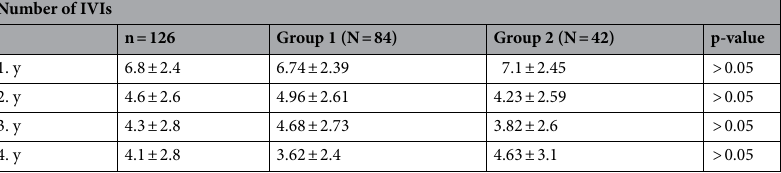
Table 3. The number of injections in both study eyes. Group 1 (response group, n = 84): eyes that showed a therapeutic response to intravitreal bevacizumab. Group 2 (non-response group, n = 42): eyes that did not show a therapeutic response to intravitreal bevacizumab.